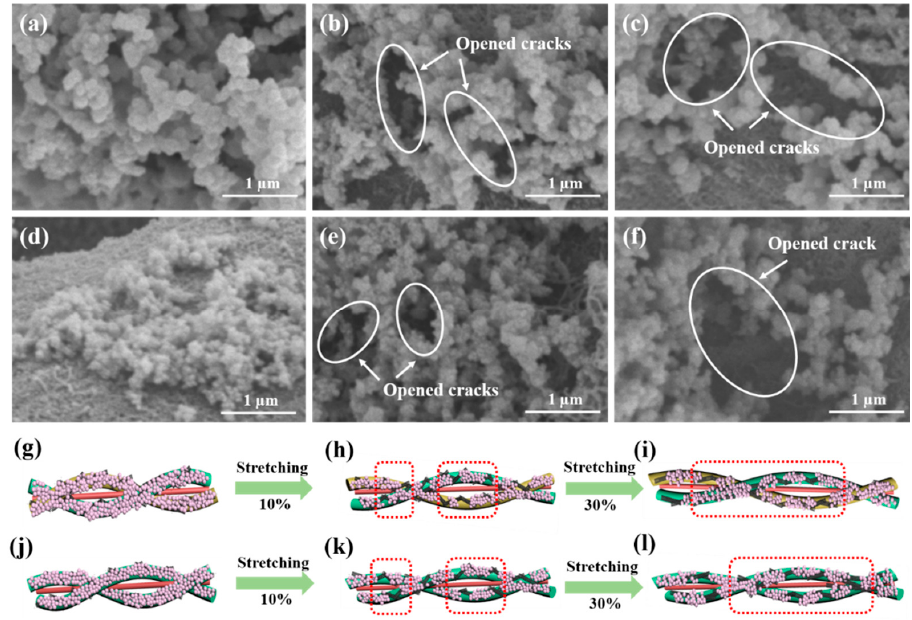
Figure 7. The sensing mechanism of the DEF/c-MWCNTs/PPy sensor under tensile strain. ( a – c ) The SEM images of polyester fiber (warp yarn)-loaded c-MWCNTs and PPy with 0, 10, and 30% strain of warp sensor. ( d – f ) The SEM images of cotton fiber (warp yarn)-loaded c-MWCNTs and PPy with 0, 10, and 30% strain of weft sensor. ( g – i ) The distribution of the c-MWCNTs and PPy with 0, 10, and 30% strain of warp sensor. ( j – l ) The distribution of the c-MWCNTs and PPy with 0, 10, and 30% strain of weft sensor.